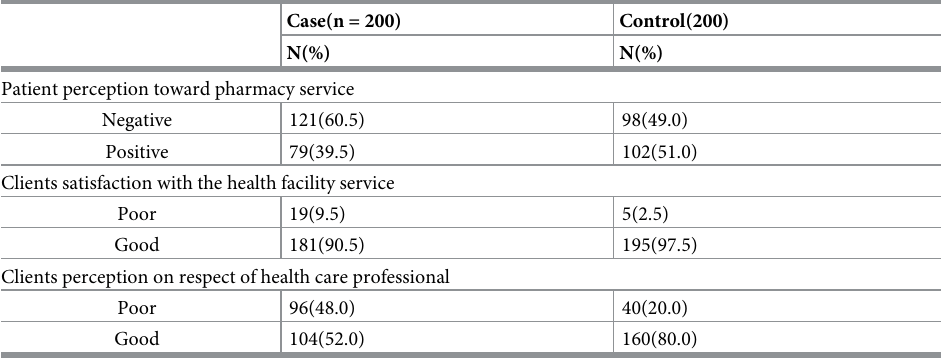
Table 4. Patient perception towards health system related factors affecting delay in seeking health care from pub- lic health facilities of Arba Minch town, south Ethiopia,